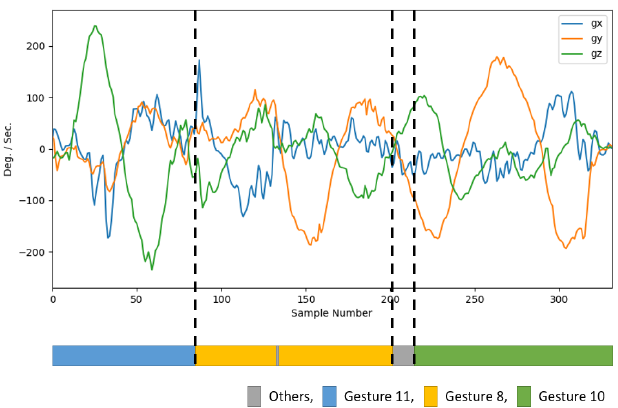
Figure 15. An example of test sequence produced by a gyroscope containing three gestures (Gesture 11, Gesture 8, and Gesture 10). The bottom of the figure reveals the gesture-spotting results by PairNet.